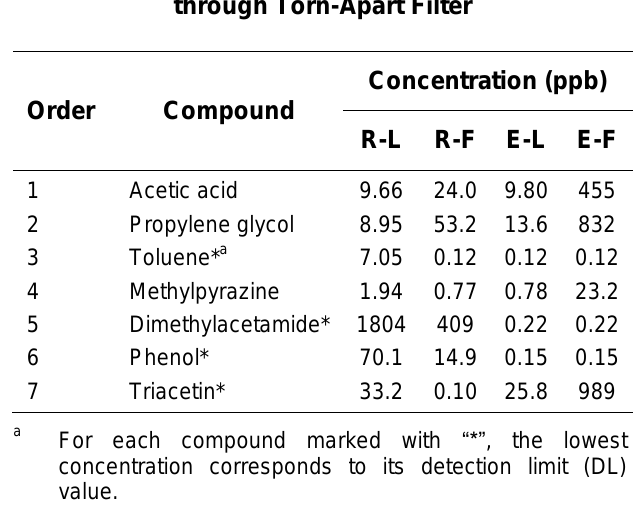
concentration corresponds to its detection limit (DL)